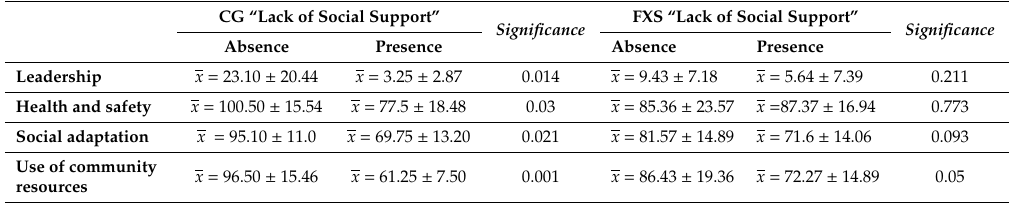
Table 5. Linear regression model with Interaction of “Lack of Social Support” with Group on “leadership”, “Health and security”, “Use of community resources”, “Social